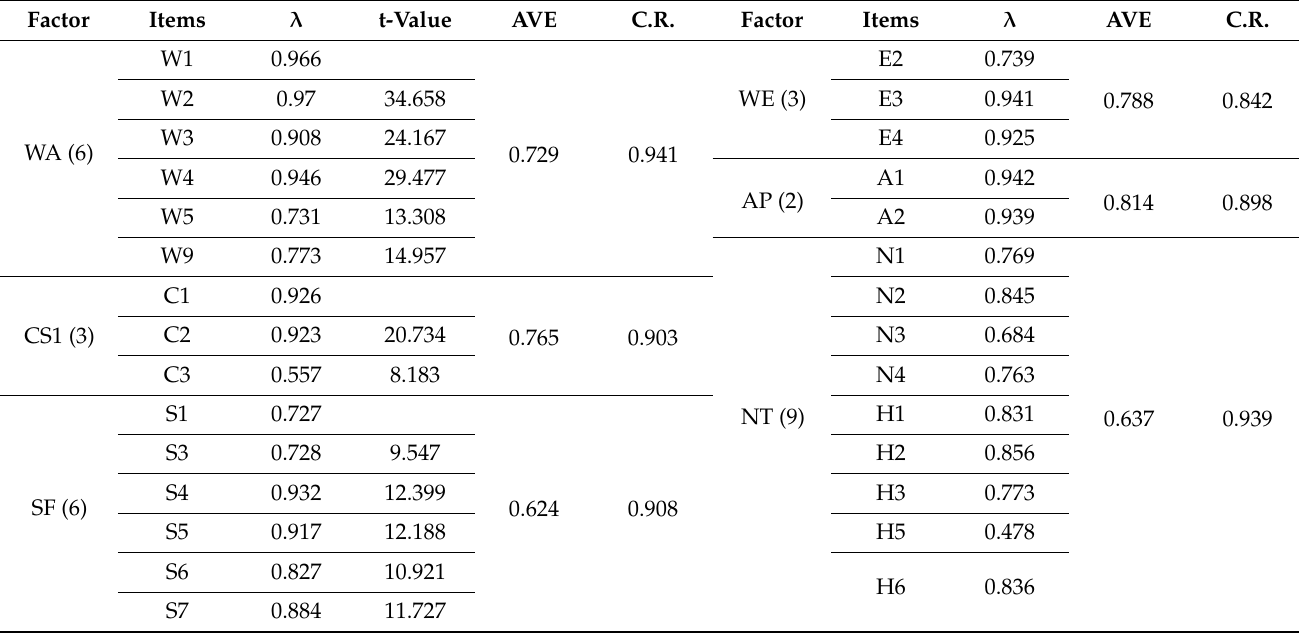
Table 4. Confirmatory factor analysis